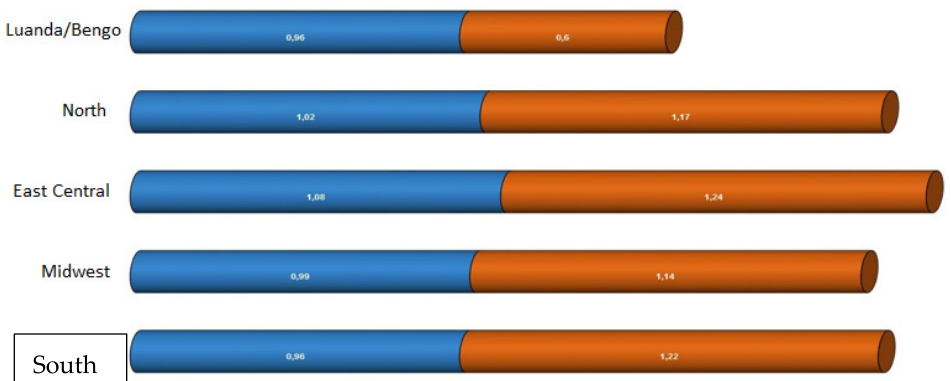
Figure 11. Relative unemployment rates in Angola. Source: Adapted from Report on Inequalities and Asymmetries in Angola. CEIC.